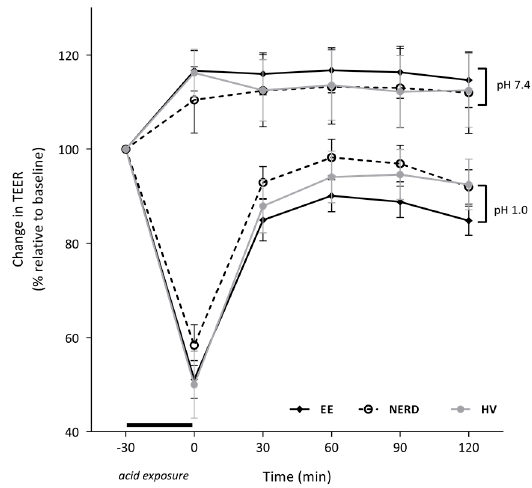
Figure 2. Reduction and recovery of TEER after 30 min of luminal acid exposure. Area under the curve value was larger in NERD patients when compared to EE patients ( p < 0.05).